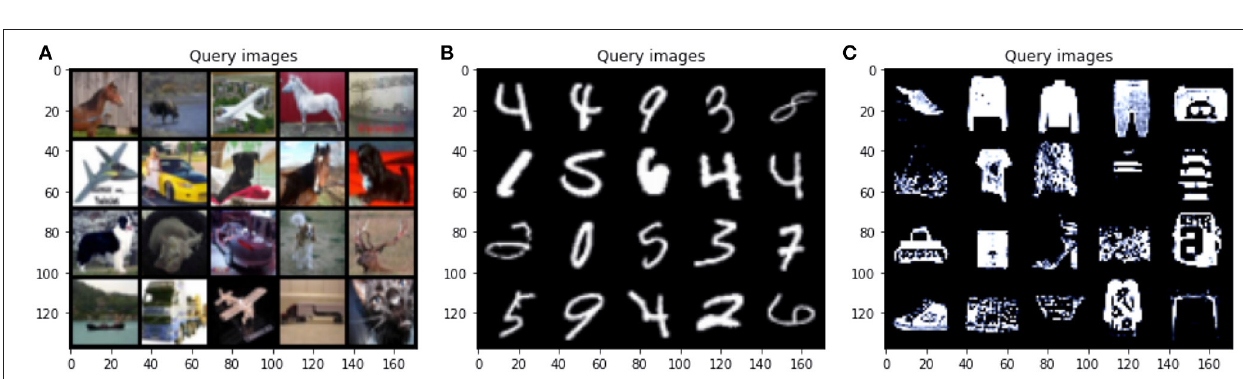
which are most different from the current labeled